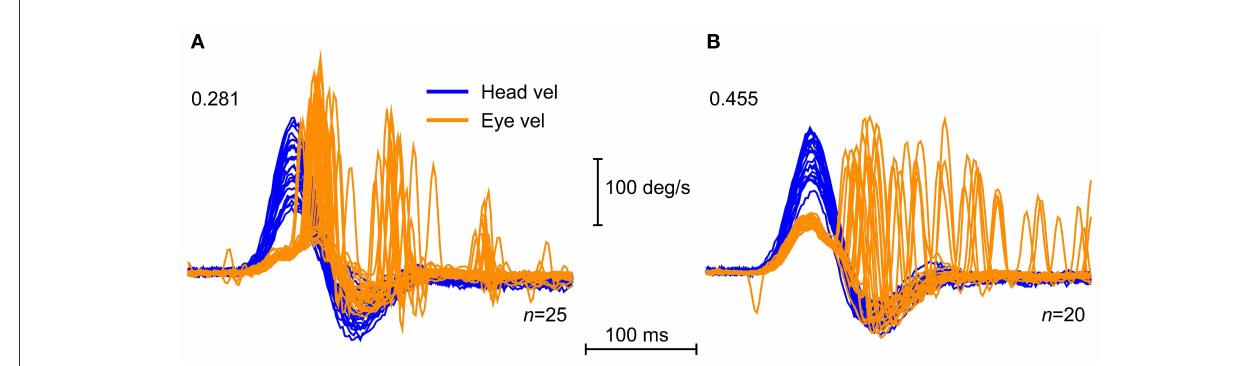
FIGURE14 Saccadic clustering. Time series of vHIT for horizontal impulses toward the affected side for two patients after vestibular schwannoma removal, showing examples of clustered saccade pattern (A) , and disorganized saccade pattern (B) . The clustered saccades here appear in three main time intervals, one toward the end of the impulse, and two more clusters after the impulse. This pattern is characteristic of a patient who is compensating for the loss of function on the affected side. The disorganized saccades of the other patient in (B) do not show the same clustering, but are distributed more uniformly after the end of the impulse. The gains of the VOR are shown on each plot [Reproduced with permission from Curthoys and Manzari (11)].